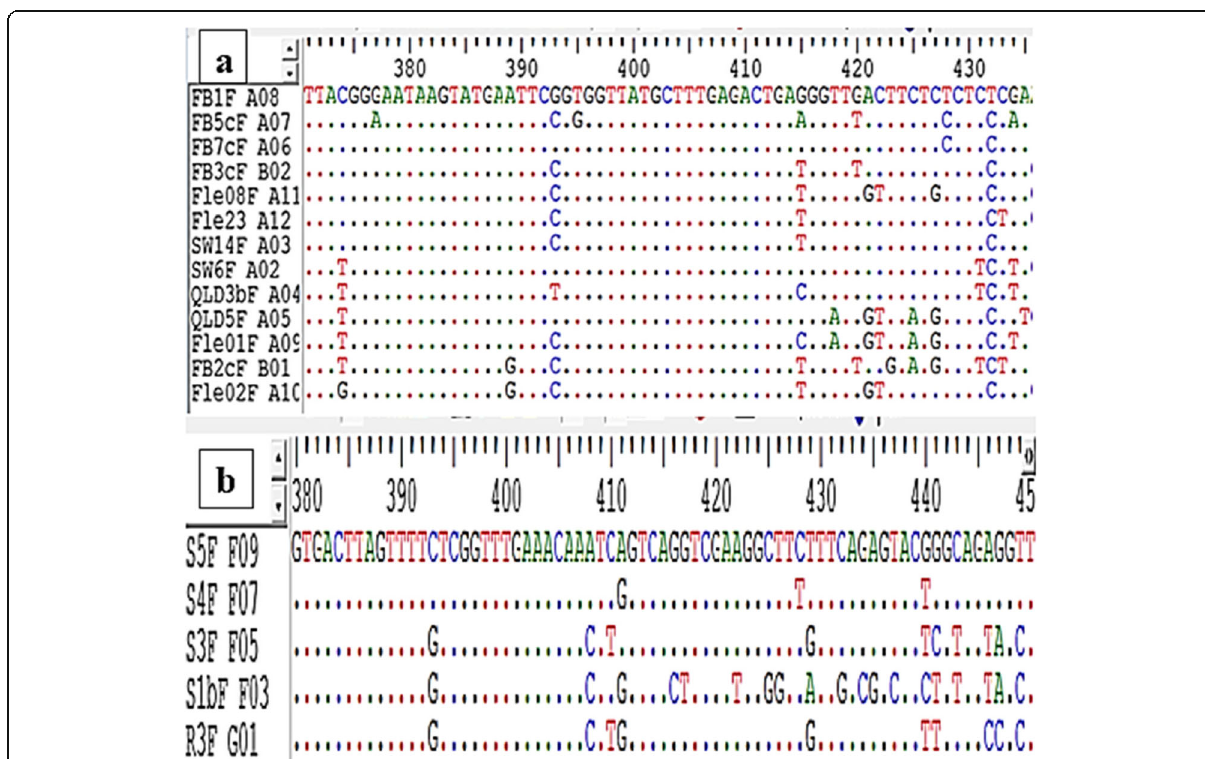
Fig. 4 Polymorphic sites detected by using primers LrEPSP_F and LrEPSP_R in the sequencing of EPSP study. a For the 13 flaxleaf fleabane populations collected from different locations across Australia. b For the 4 individuals of the susceptible population (FBTAR) and 1 individual of the resistant population (FSEQLD7) of flaxleaf fleabane. All polymorphic sites are displayed comparative to Lolium rigidum sequence. Polymorphic sites are shown, while dots point to nucleotides identical to Lolium rigidum . The numbers above the partial gene sequences represent the base pair numbers between 371 to 435 bp for a and between 380 to 450 bp for